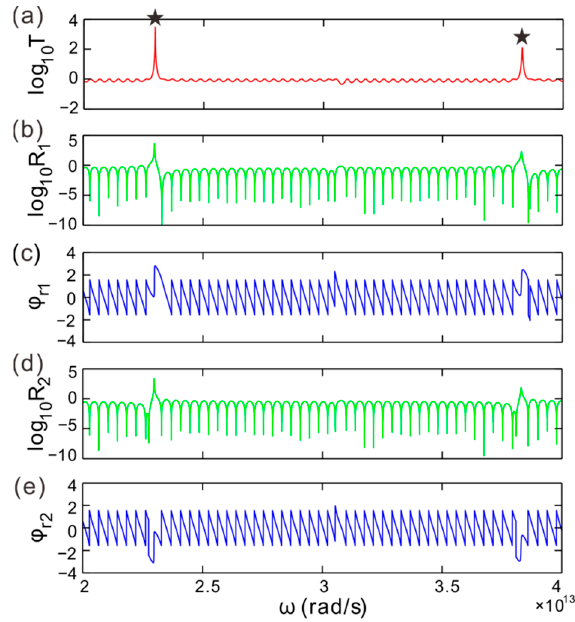
Figure 2. The calculated spectra for the anti-PT-symmetric PCs. The transmission spectrum T ( a ), the reflection spectrum R 1 ( b ), and the phase of reflection coefficient ( c ) for light incident from the left, respectively. The reflection spectrum R 2 ( d ), and the phase of reflection coefficient ( e ) for light incident from the right, respectively. The gain-loss factor q = 2.